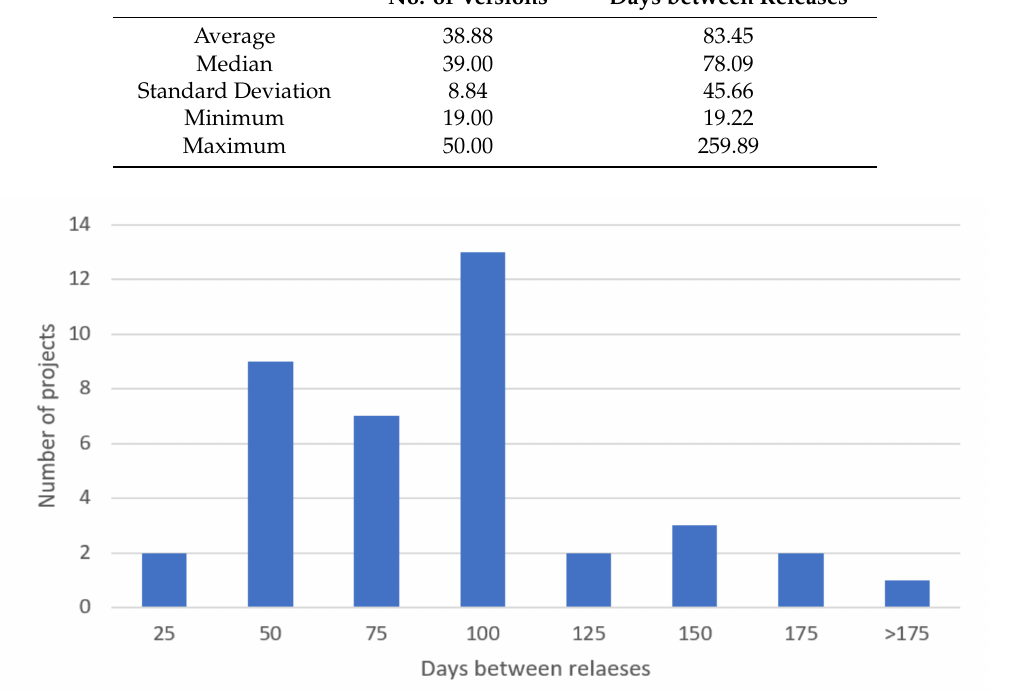
Figure 3. The distribution of periods between releases of all projects in the